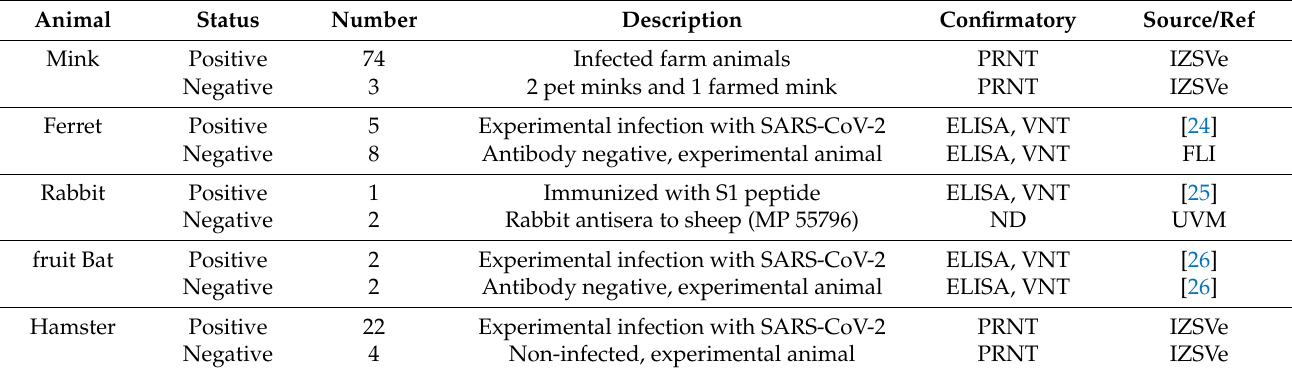
Table 1. Description of the sera tested by